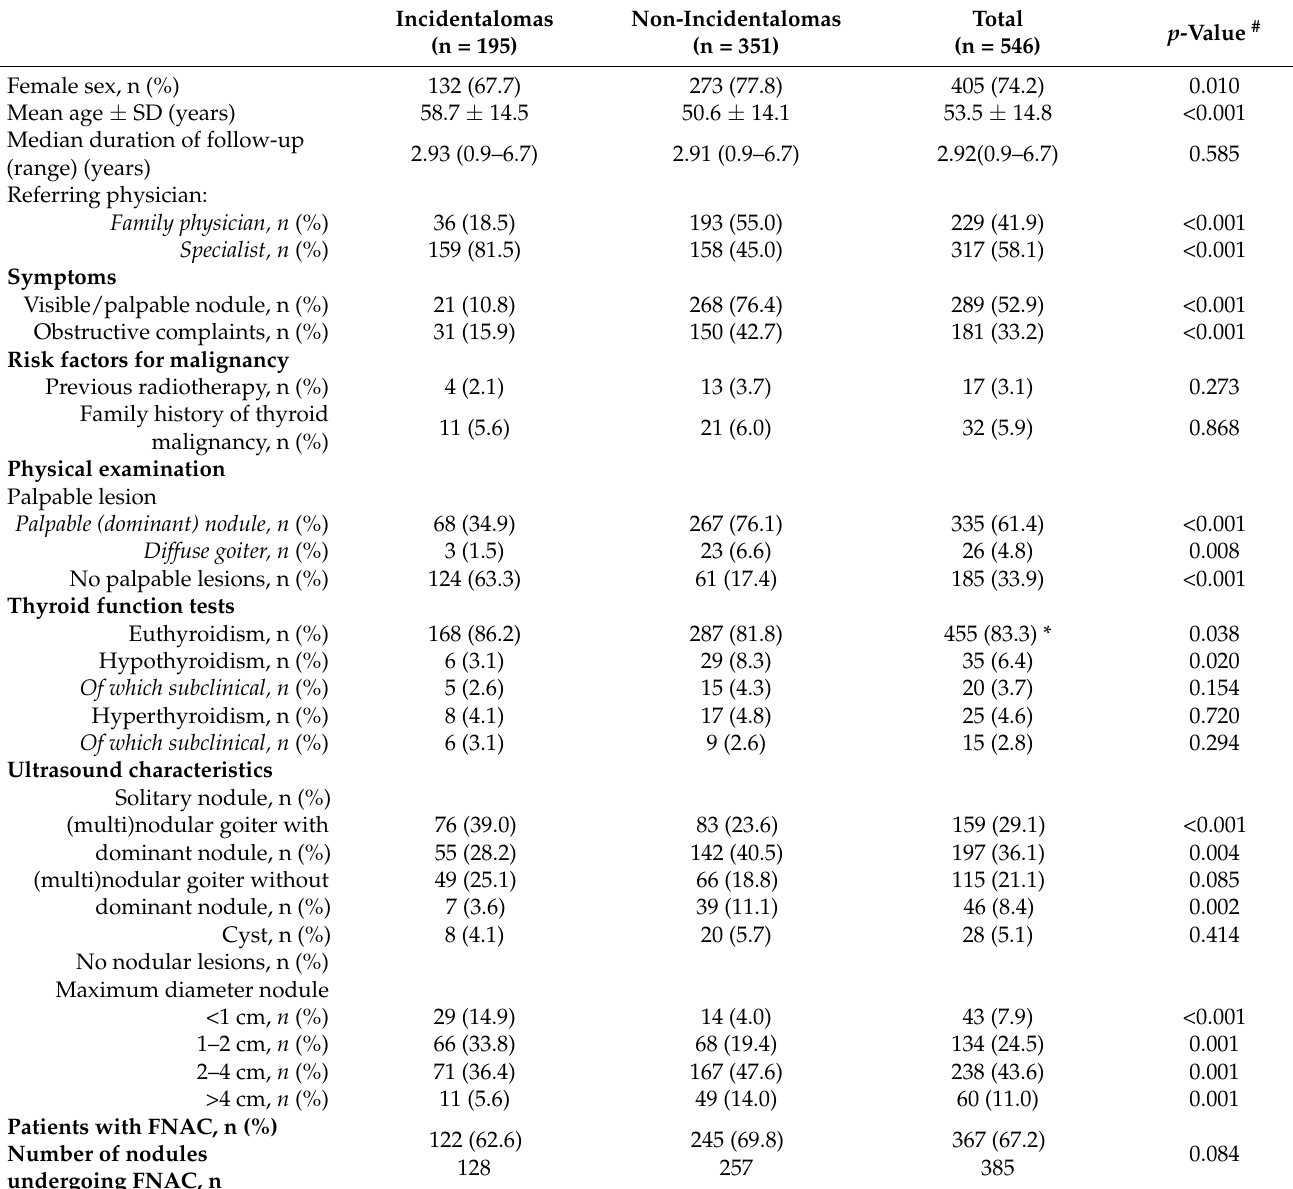
Table 1. Clinical characteristics of the